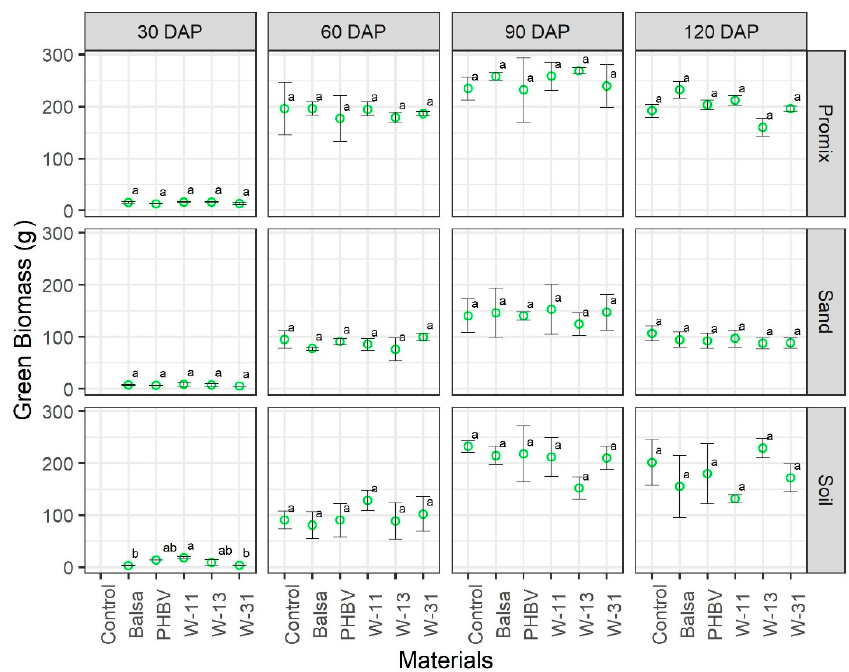
Figure 5. Comparison of maize green biomass (g) in three growing media (Promix, sand, and soil) and four growth stages (30, 60, 90, and 120 days after transplanting (DAP)). Different lowercase letters indicate significant differences at α = 0.05, whereas same letters indicate no significant difference across compared treatments.